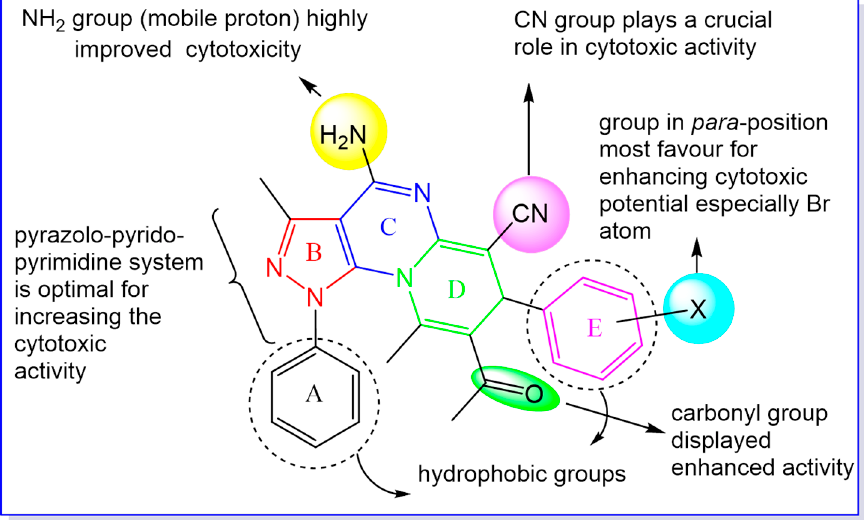
Figure 3. The structure–activity relationship (SAR) of designed scaffolds cytotoxic agent 7 . The highest cytotoxicity for A2780 cancer cell lines was found again for compound 7e (EC 50 = 9.1 ± 1.6 µ M). In this series, compounds 7g and 7b (EC 50 = 14.5 ± 2.2 and 14.6 ± 2.2 µ M, respectively) showed noteworthy activity as compared to other analogs, and their EC 50 values ranged between 18.0 ± 3.0 and 27.5 ± 8.1 µ M. Unfortunately, compound